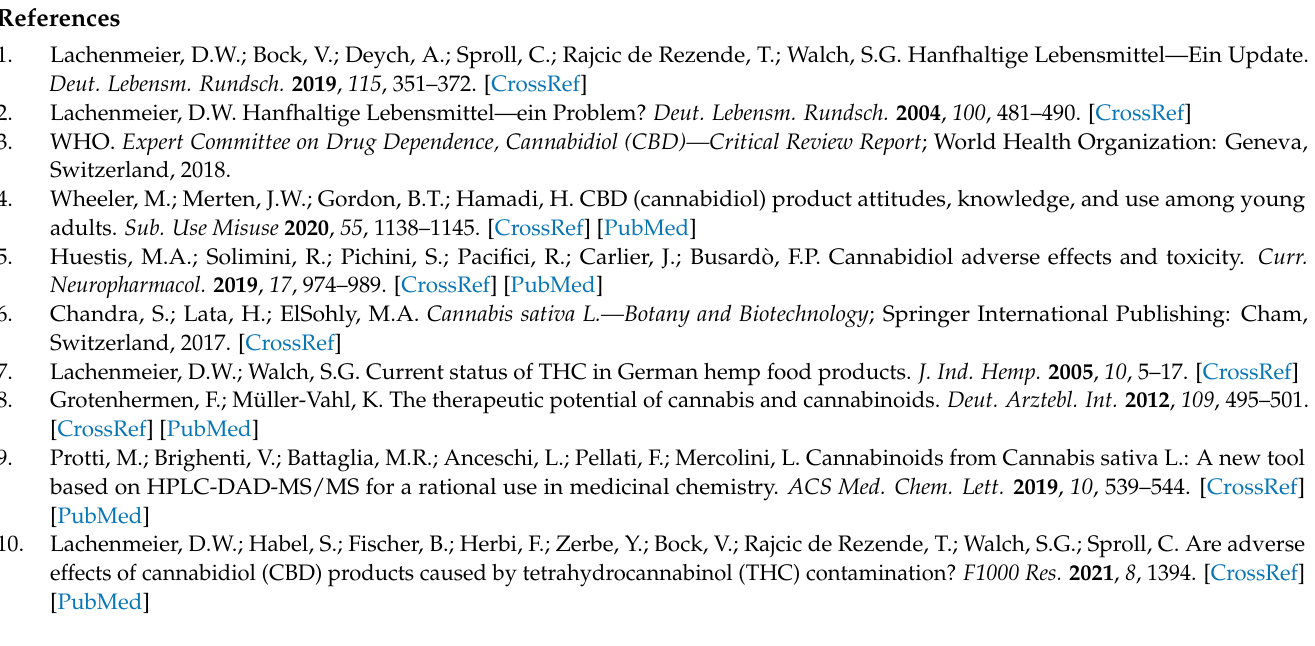
for all hemp seed samples, Table S3: Calculations for all hemp seed oil samples, Table S4: Calculations for all hemp tea samples, Table S5: Calculations for all hemp food supplement samples, Table S6: Summary for all food product